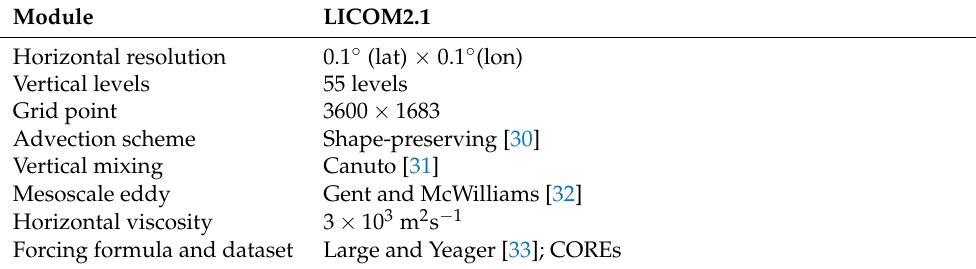
Table 2. Configurations of the test